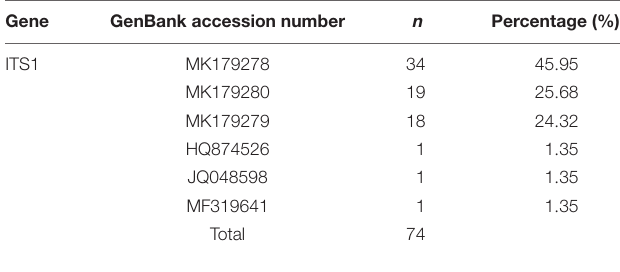
TABLE 2 | ITS1 sequences of C. sinensis from Heilongjiang Province in this study.